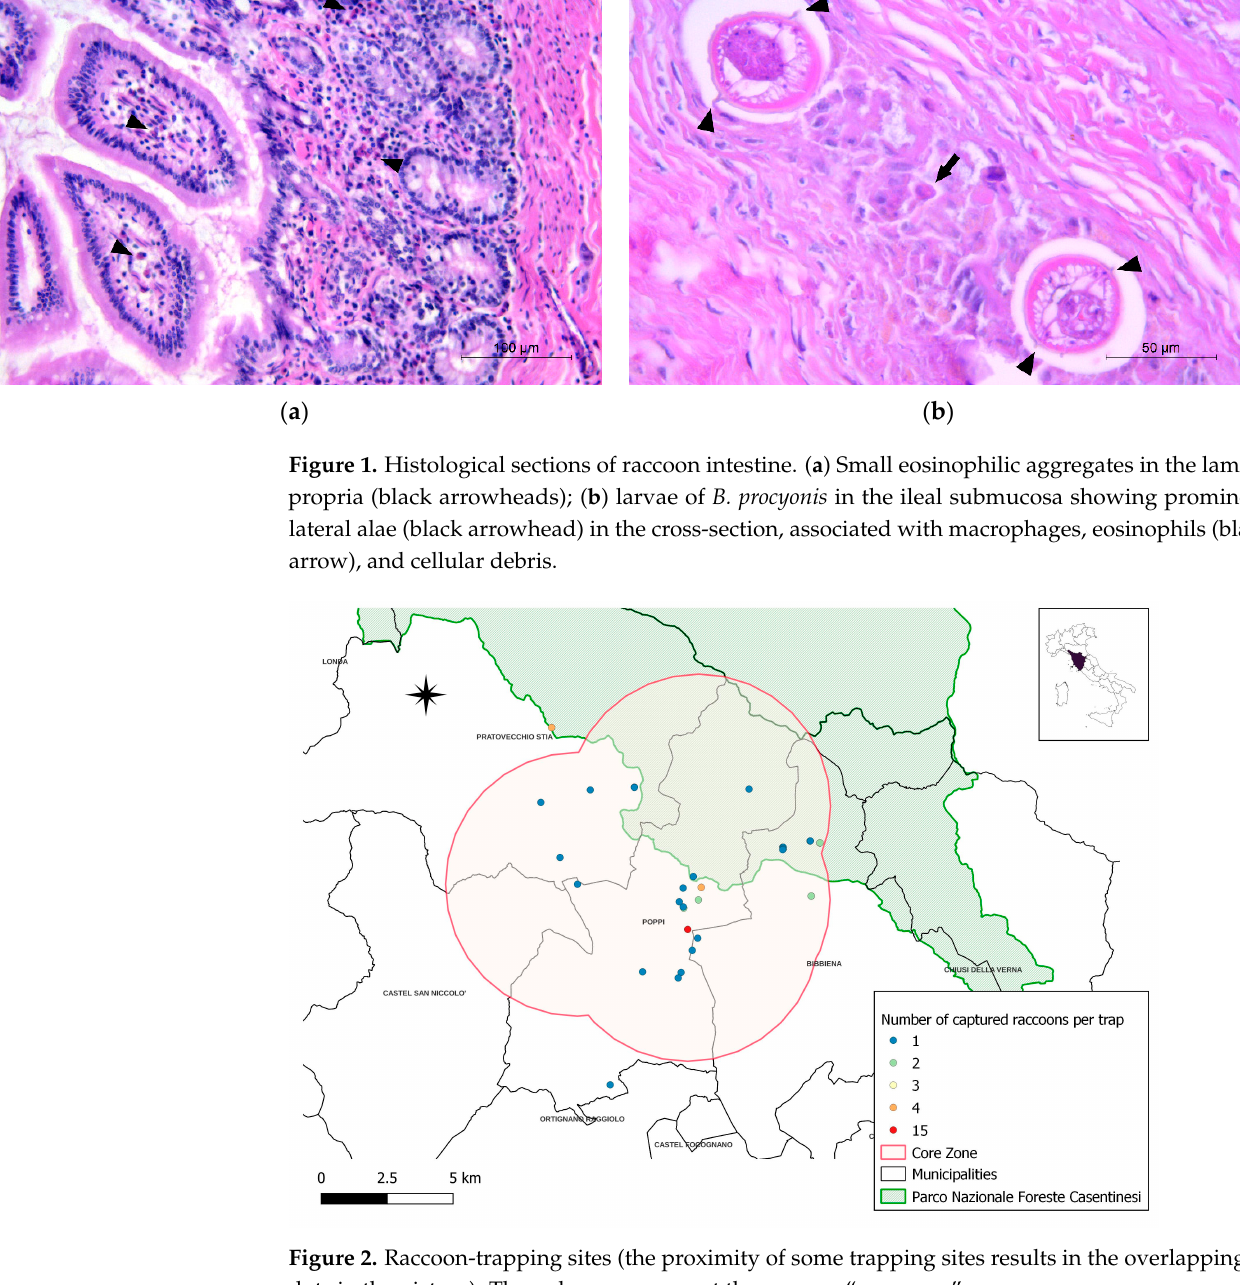
Figure 1. Histological sections of raccoon intestine. ( a ) Small eosinophilic aggregates in the lamina propria (black arrowheads); ( b ) larvae of B. procyonis in the ileal submucosa showing prominent lateral alae (black arrowhead) in the cross-section, associated with macrophages, eosinophils (black arrow), and cellular debris.